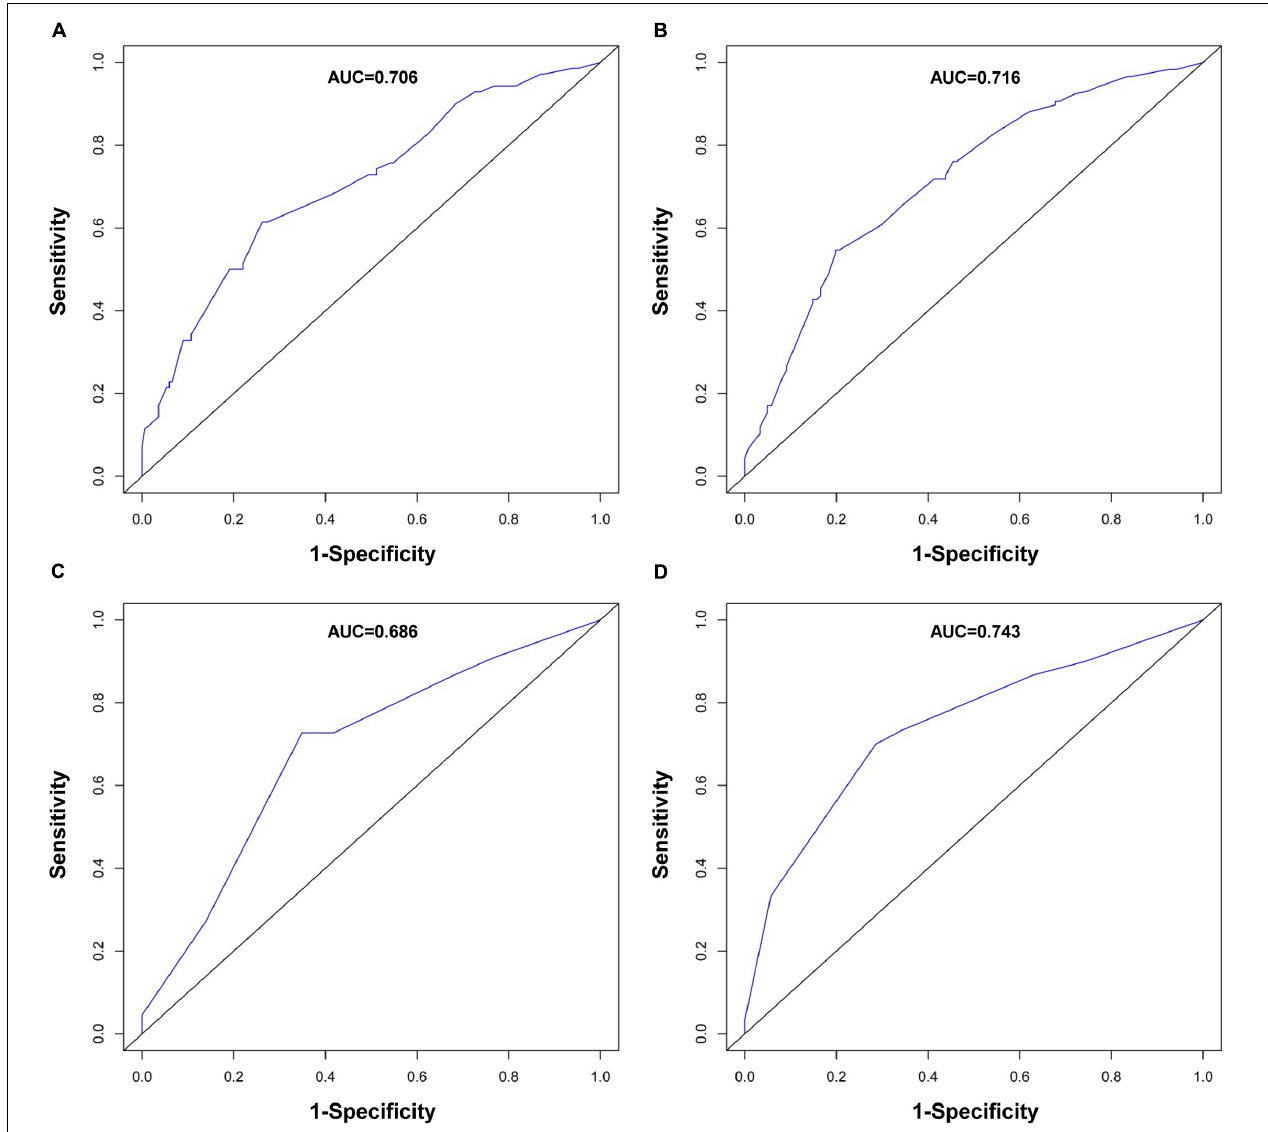
FIGURE 3 | ROC curve evaluating predictive performance of the nomogram for 1-year RFS (A) and 3-year RFS (B) in the training cohort and 1-year RFS (C) and 3-year RFS (D) in the validation